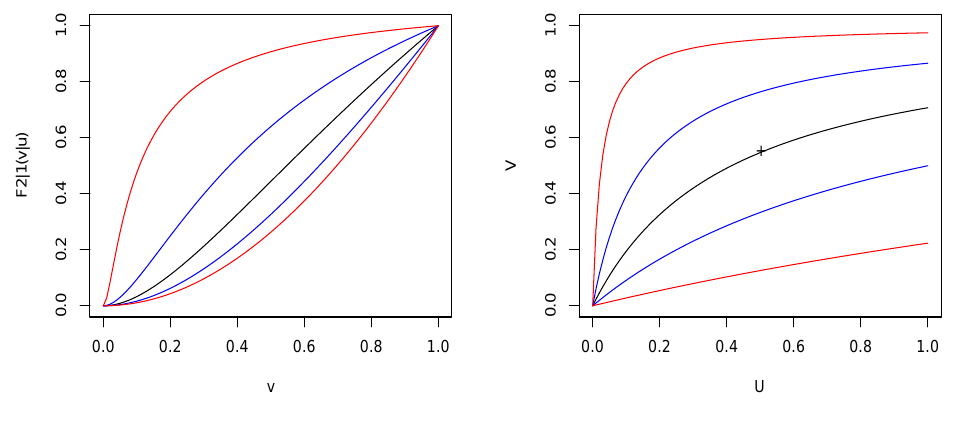
Figure 4: Conditional distribution functions (left) of V | U = u for the Clayton copula in Example 2.2 and u = 0.5, 0.25, 0.75, 0.05, 0.95 (black, blue top, blue bottom, red top, red bottom). Quantile regression curves q 2 v = 0.5, 0.25, 0.75, 0.05, 0.95 (black, blue bottom, blue top, red bottom, red top). The + point represents the conditional median m 2 | 1 = (0.5, 0.5469182)